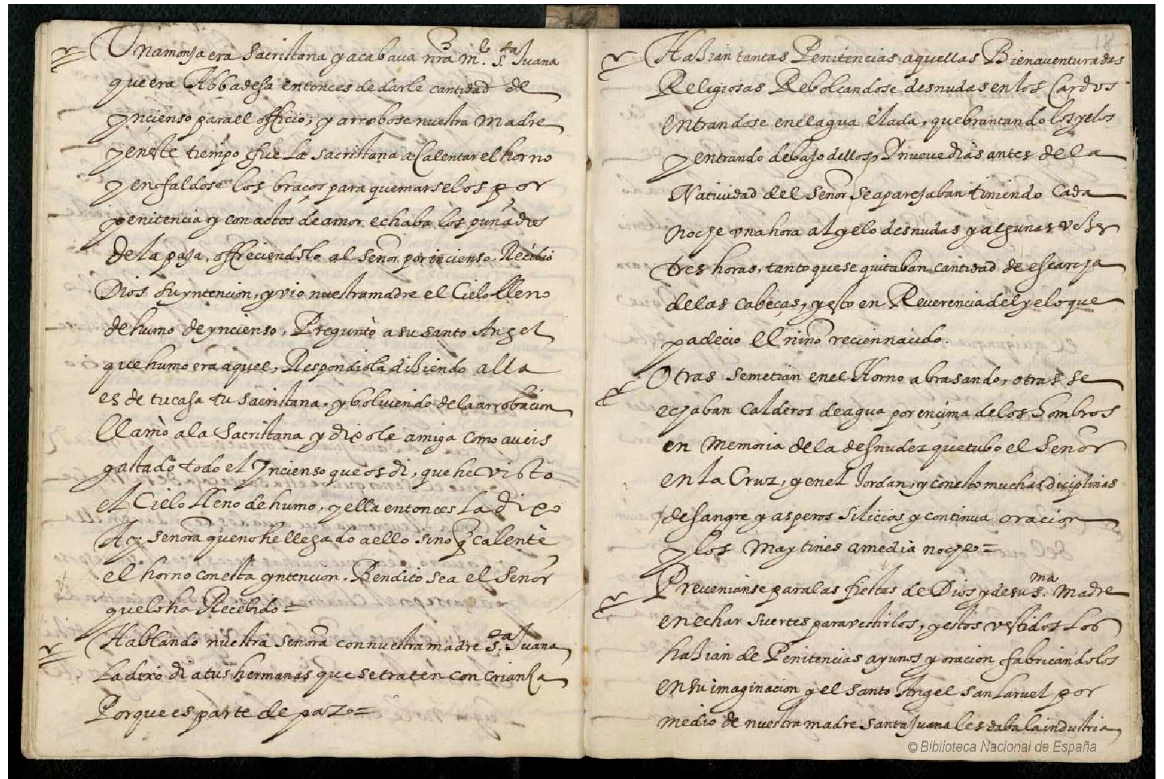
Figure 3. Libro de la casa , 17th century; Madrid, Biblioteca Nacional de España, MS 9661, ff. 17v-18r (Source: Biblioteca Digital Hispánica/ BNE. Imagen procedente de los fondos de la Biblioteca Nacional de España).